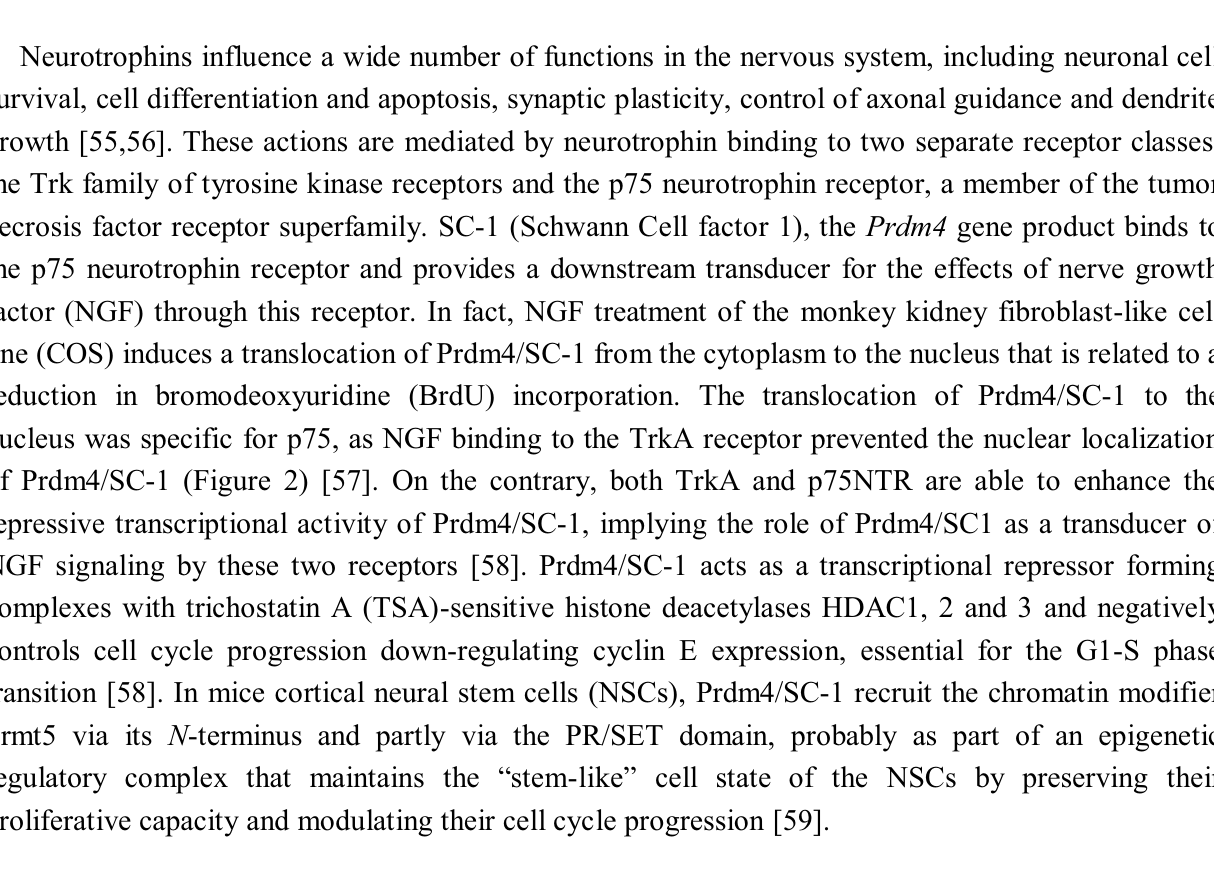
Figure 2. Prdm4/SC-1 (Schwann Cell factor 1) provides a downstream transducer for the effects of nerve growth factor (NGF) through the p75 neurotrophin receptor and forms an epigenet (cid:76)(cid:70)(cid:3)(cid:85)(cid:72)(cid:74)(cid:88)(cid:79)(cid:68)(cid:87)(cid:82)(cid:85)(cid:92)(cid:3)(cid:70)(cid:82)(cid:80)(cid:83)(cid:79)(cid:72)(cid:91)(cid:3)(cid:90)(cid:76)(cid:87)(cid:75)(cid:3)(cid:51)(cid:85)(cid:80)(cid:87)(cid:24)(cid:3)(cid:87)(cid:75)(cid:68)(cid:87)(cid:3)(cid:83)(cid:85)(cid:82)(cid:69)(cid:68)(cid:69)(cid:79)(cid:92)(cid:3)(cid:80)(cid:68)(cid:76)(cid:81)(cid:87)(cid:68)(cid:76)(cid:81)(cid:86)(cid:3)(cid:87)(cid:75)(cid:72)(cid:3)(cid:179)(cid:86)(cid:87)(cid:72)(cid:80) - (cid:79)(cid:76)(cid:78)(cid:72)(cid:180)(cid:3)(cid:70)(cid:72)(cid:79)(cid:79)(cid:88)(cid:79)(cid:68)(cid:85)(cid:3) state of a